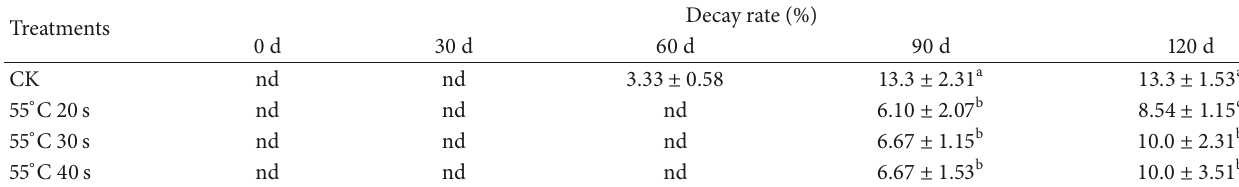
Table 1: Effects of different heat treatments on decay rate of Ponkan fruit during storage.